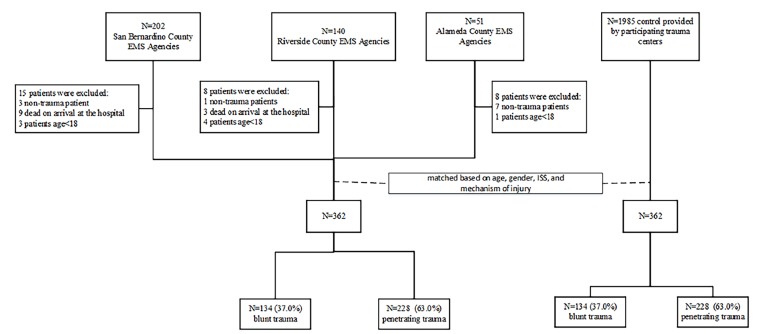
Patient flow chart.